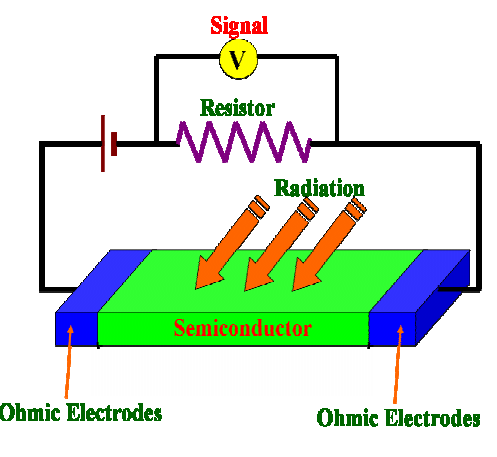
Figure 1. The schematic structure of photoconductors.